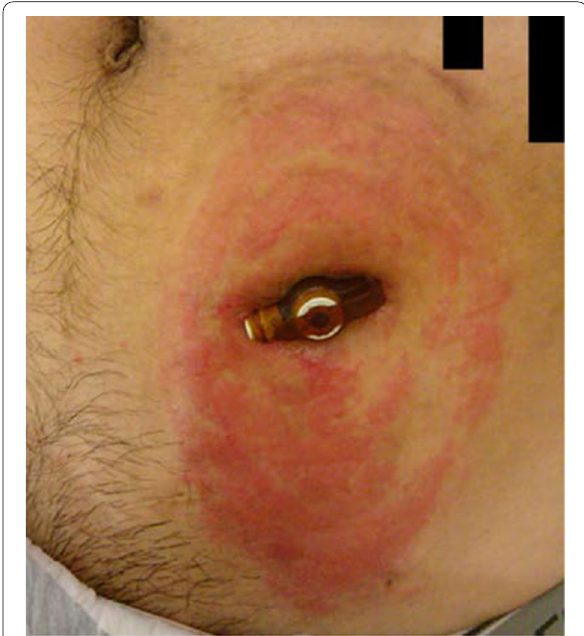
Fig. 1 The ACE procedure using a balloon-button gastrostomy tube and skin findings just before reconstruction. Dermatitis was observed around the gastrostomy